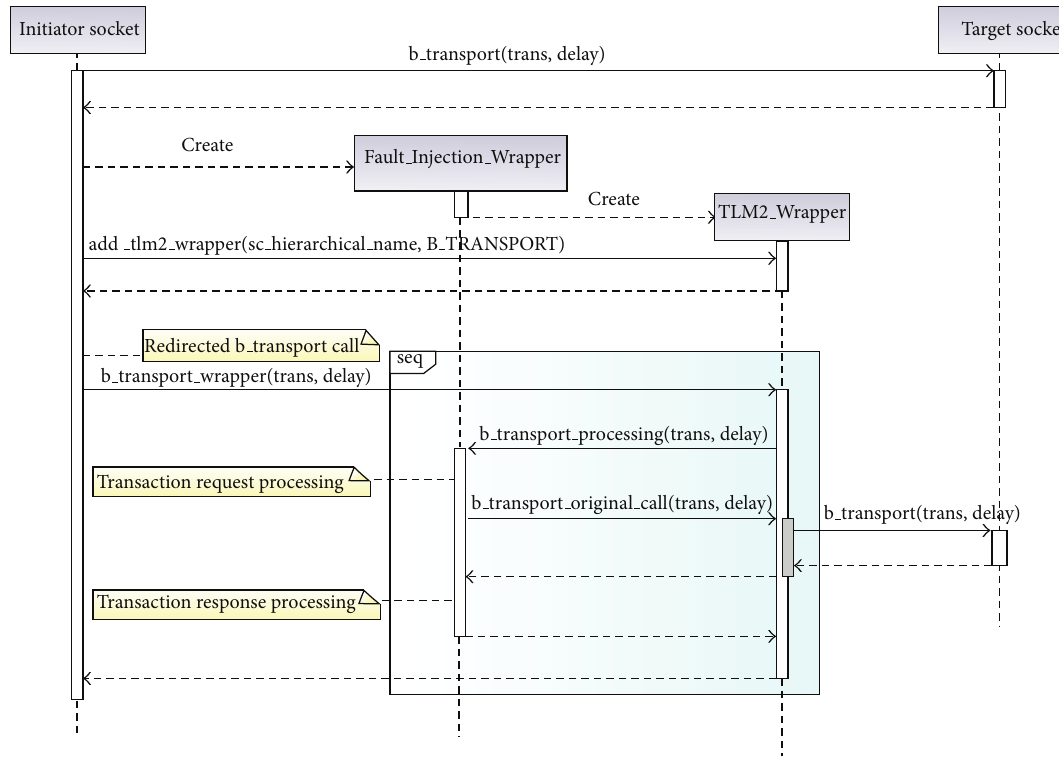
Figure 7: TLM2 wrapper sequence